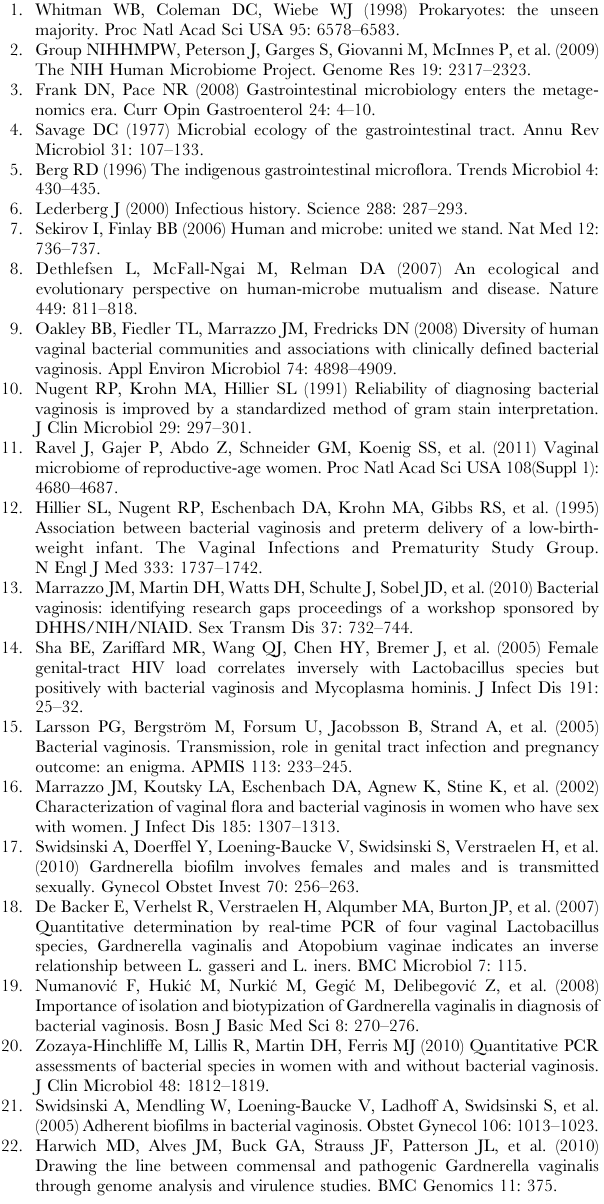
(urethra sample) bars represent male sexual partners oligotype profile. For the sake of compactness, only the more similar sample to vaginal sample from male partner were used when both MP and MU samples were available for a given couple. Table S1 Number of sequences in each sample. Number of sequences per sample in the original pyrosequencing library versus the number of sequences that were 99% or more similar to one of the full length G. vaginalis sequences in the local search database with minimum alignment length of 480bp. Table S2 Oligotype distribution among sample groups. Every column in this table shows the number of samples in a group in which the given oligotype was observed at least once. The total number of vaginal swab (VS), penile skin (PS), and urethral (U)